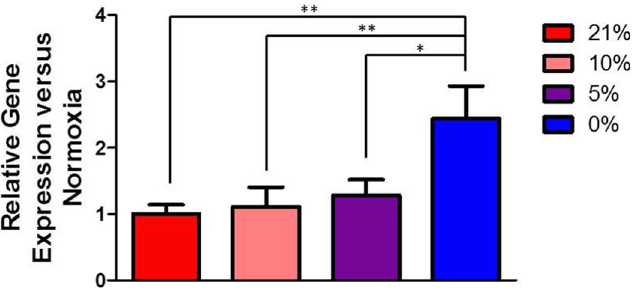
Fig 3. PCR Data. VEGFA expression in A549 cells after exposure to different oxygen conditions set-up by the insert device. Data are expressed as mean ± SD, N = 3.